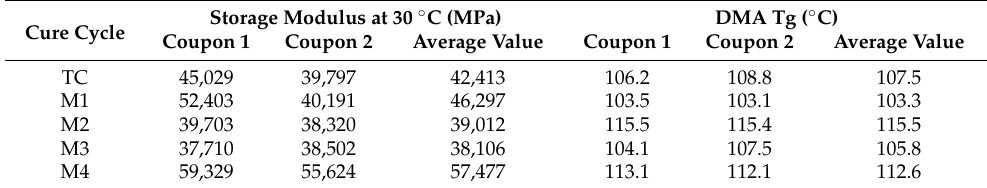
Table 2. DMA results for laminates prepared by various processes.